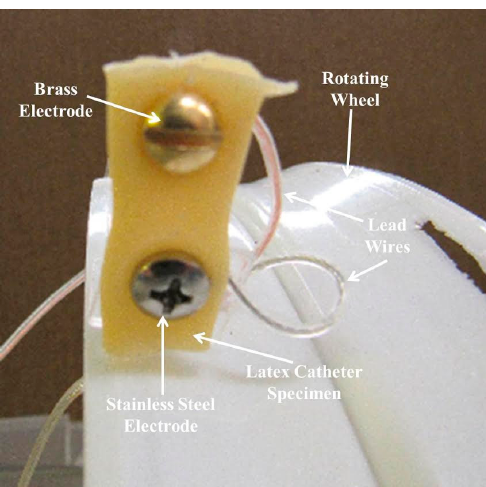
Figure 4. Sample 7, latex with electrically biased stainless steel and brass electrodes at the start of the experiment.